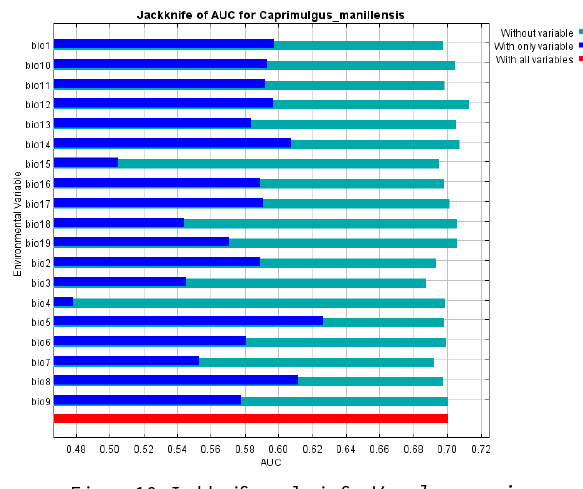
Figure 10. Jackknife analysis for V. palawanensis